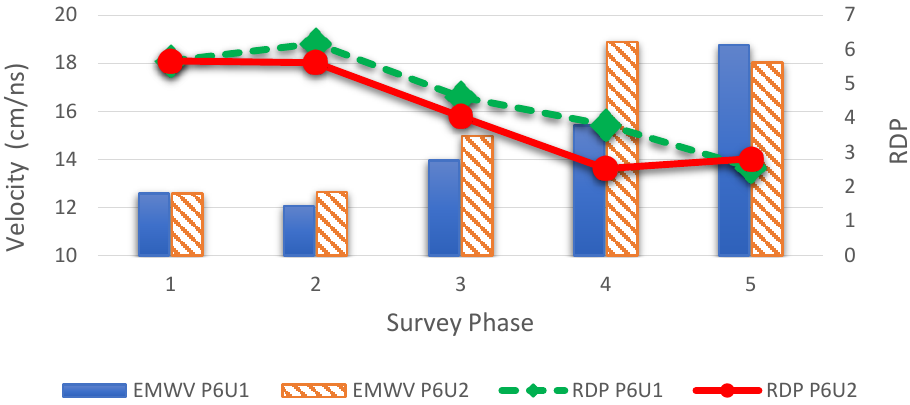
Figure 10. The change of EMWV and RDP values during the lifecycle of the railway track in section P3.